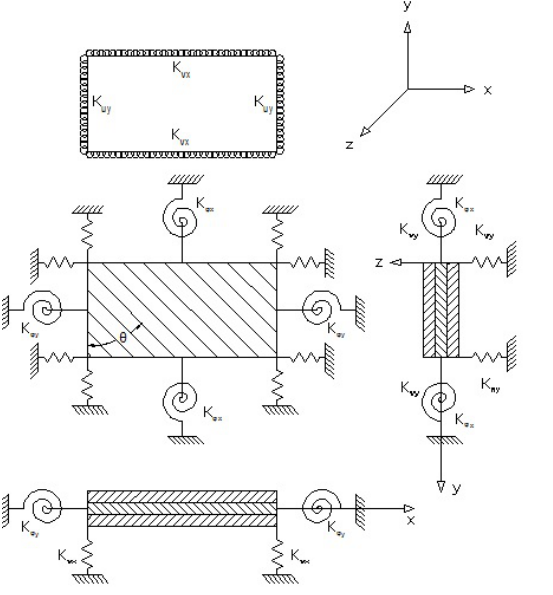
Figure 1. The geometry and boundary conditions of a laminated plate